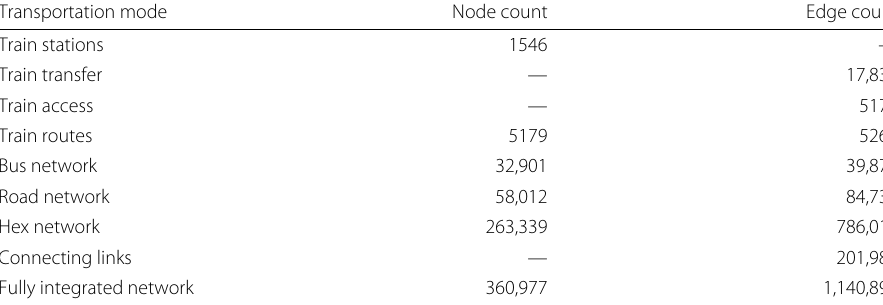
Table 1 Summary of basic network features for the fully integrated